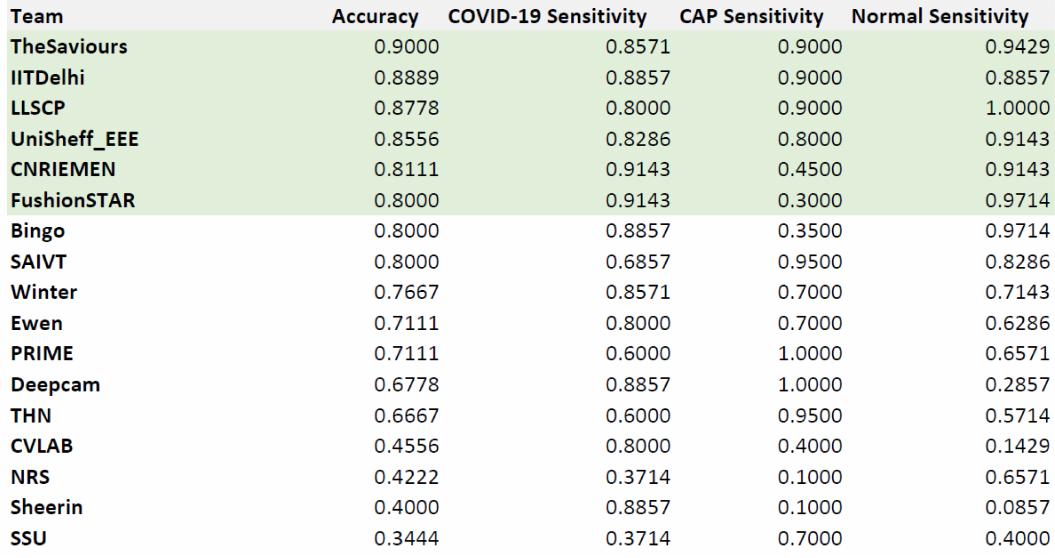
Figure 11. The final results of the three test sets.